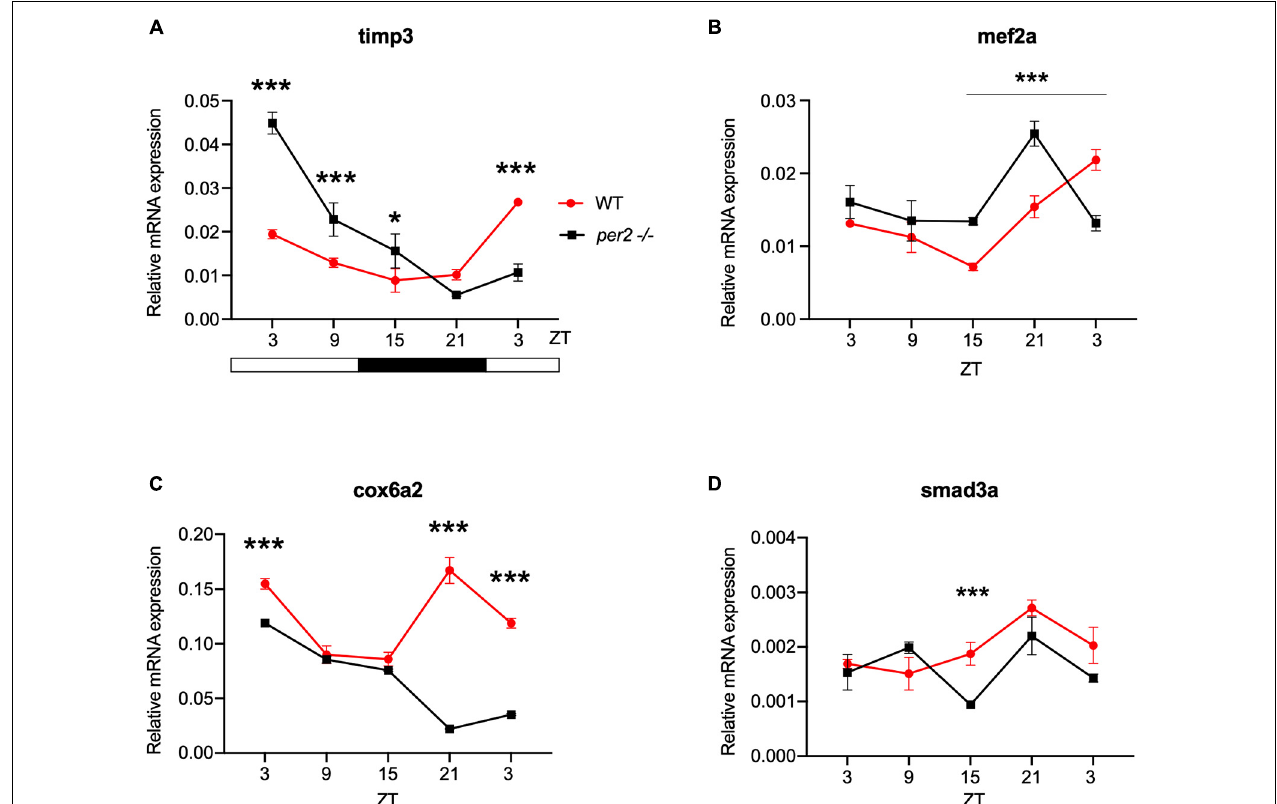
FIGURE 5 | Per2 knockout alters the rhythmic mRNA expression of clock-controlled genes in the adult zebrafish heart. qRT-PCR analysis of expression levels of four putative CCGs (A) timp3, (B) mef2a , (C) cox6a2, and (D) smad3a in WT and per2 KO heart tissues. Sets ( n = 3) of 4 WT and per2 KO fish (each set containing two males and two females) were maintained under LD cycle (14 h light-10 h dark) conditions, hearts were dissected and pooled for RNA extraction at 6-h intervals during a sampling window of 24 h. Mean mRNA relative expression ± SD is plotted on the y -axis; zeitgeber time (ZT) is plotted on the x -axis. Zeitgeber times are indicated for each sample. ZT0 corresponds to lights-on, ZT14 to lights-off. A change in rhythm was observed for timp3 , cox6a2, mef2a, and smad3a , as determined by a significant ANOVA Genotype × Time interaction effect for all genes ( p < 0.01, see Table 1 ). Asterisks represent levels of significance in comparing the two genotypes at each time point individually, corrected by Sidak’s method (*** p < 0.001, * p <